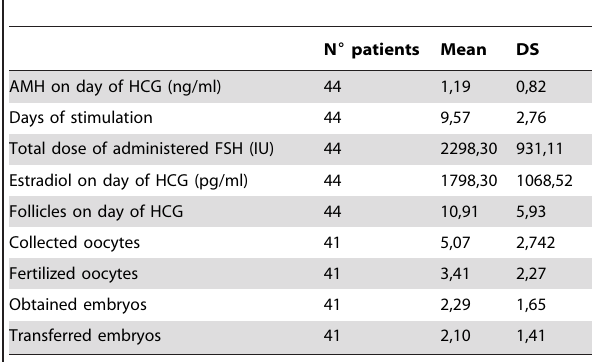
Table 2. Ovarian response and reproductive outcome during ovarian stimulation.